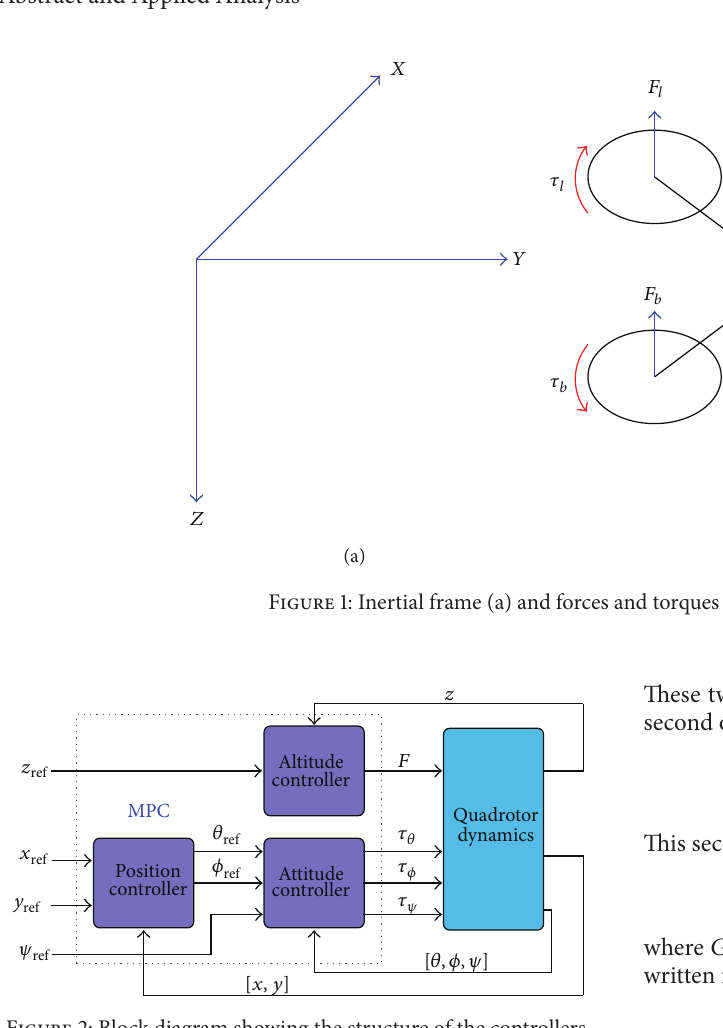
Figure 2: Block diagram showing the structure of the controllers.